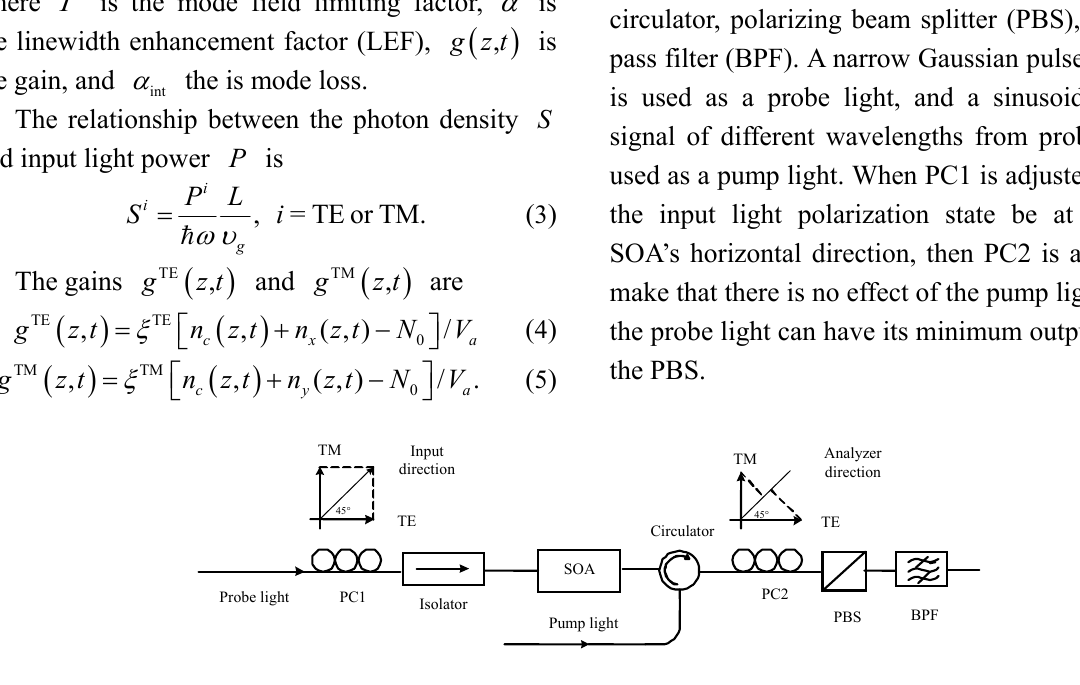
Fig. 1 All-optical sampling scheme based on the NPR effect of the